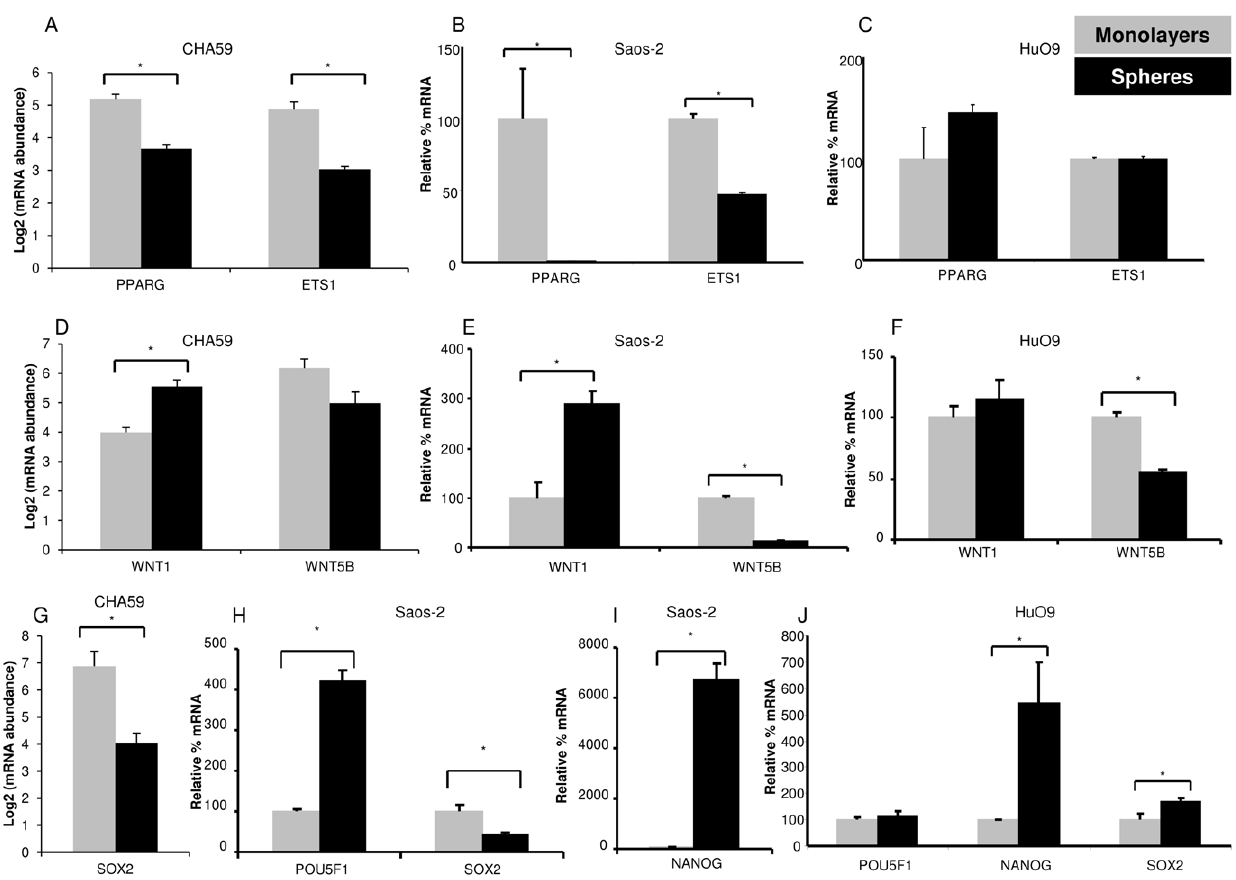
Figure 3. Expression of transcription factors and signaling molecules in CHA59, Saos-2, and HuO9 monolayers and spheres. (A, D, G) CHA59 cells, transcript abundance measured by microarray analysis, (B, E, H, I) Saos-2 cells, transcript level measured by real-time RT-PCR. (C, F, J) HuO9 cells, transcript level measured by real-time RT-PCR. *p , 0.05.